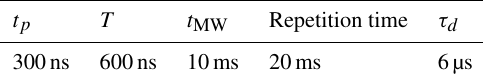
Table 1. Parameters used in EDNMR experiment for 0.5, 10 and 20mM radical concentration (see Fig.